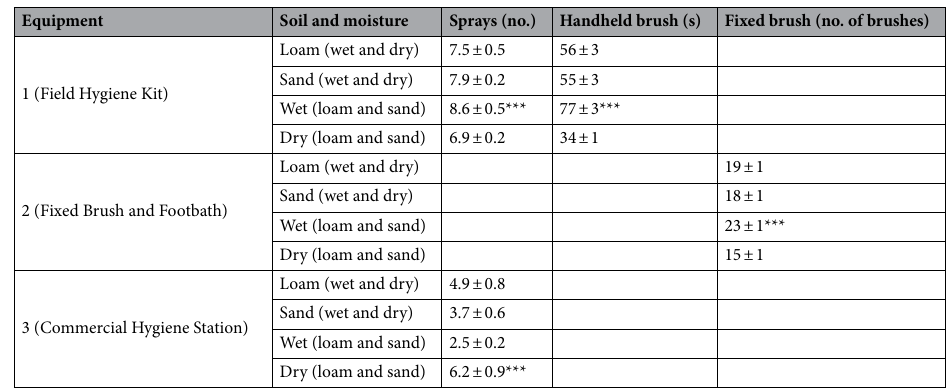
Table 1. Mean ± SE numbers of sprays, time spent brushing with a handheld brush and number of brushes with a fixed brush by volunteers in experiments involving three types of equipment and four soil/moisture types. Within each treatment for each equipment, the significance of differences in means between loam and sand OR wet and dry soil types was determined by t tests; a significant difference is indicated by *** (P <